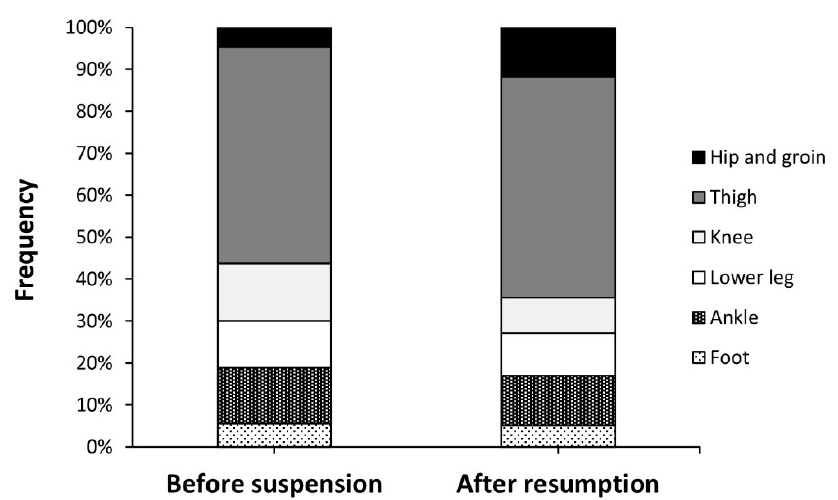
Figure 2. Distribution of lower limb injuries in professional football players before the suspension of LaLiga due to the COVID-19 pandemic and after the resumption of the